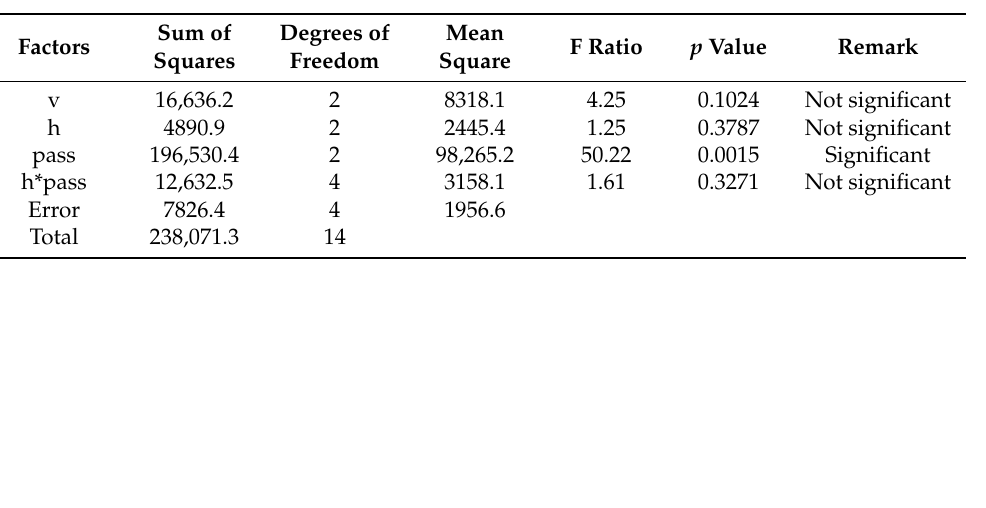
Table 6. ANOVA table for axial residual stress on the